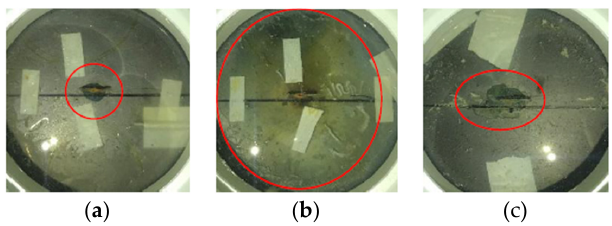
Figure 14. Visual inspections of the three tested samples under combined loading–corrosion tests at the end of the experiments: ( a ) B1, ( b ) B2, and ( c ) B3.